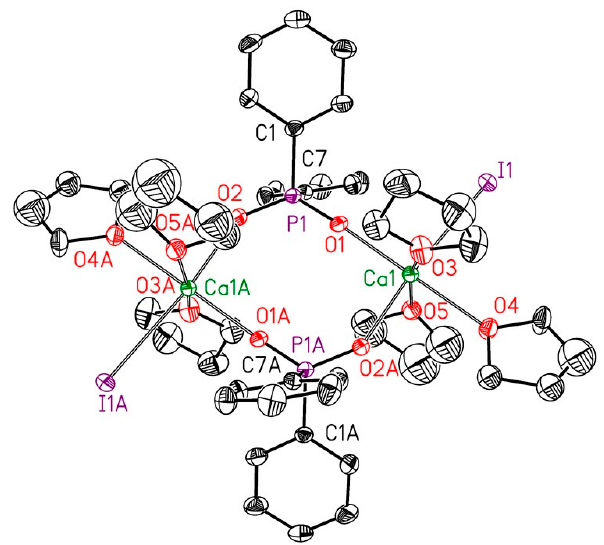
Figure 6. Molecular structure and atom numbering scheme of [(thf) 3 Ca(I)( µ -O 2 PPh 2 )] 2 ( 3b ). Symmetry related atoms are marked with the letter “A”. The ellipsoids represent a probability of 30%; H atoms and disordering of the thf ligands are not shown. Bond lengths of the inner core (pm): Ca1–I1